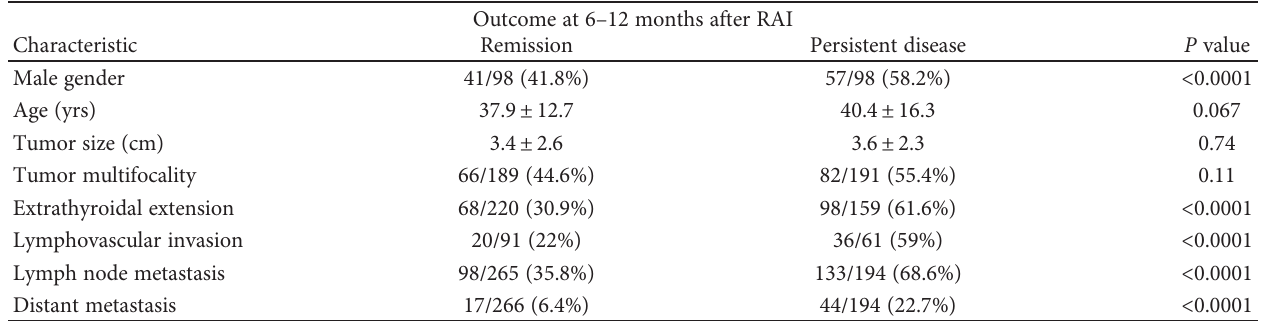
Table 4: Univariate analysis of predictive factors of outcome in the short term (6 – 12 months after RAI